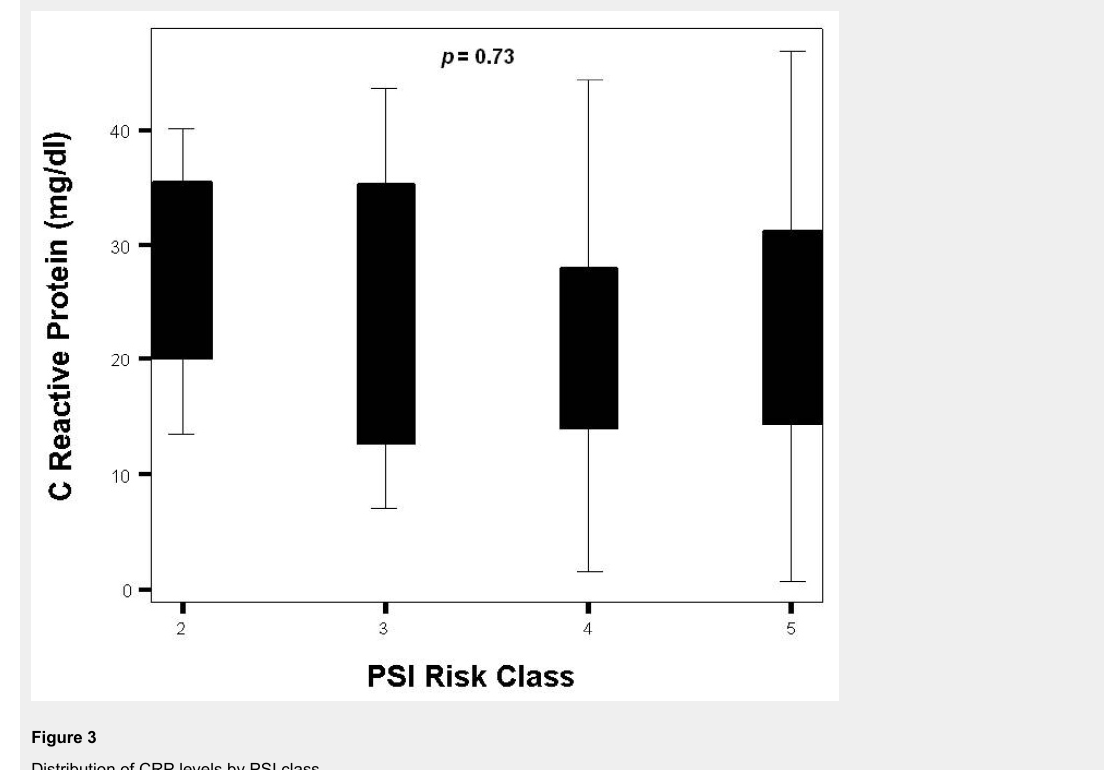
Figure 3 Distribution of CRP levels by PSI class.